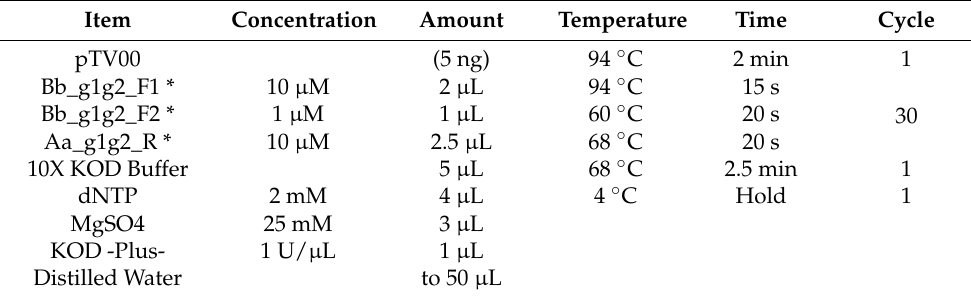
Table 9. PCR components and thermal conditions for the first insert.